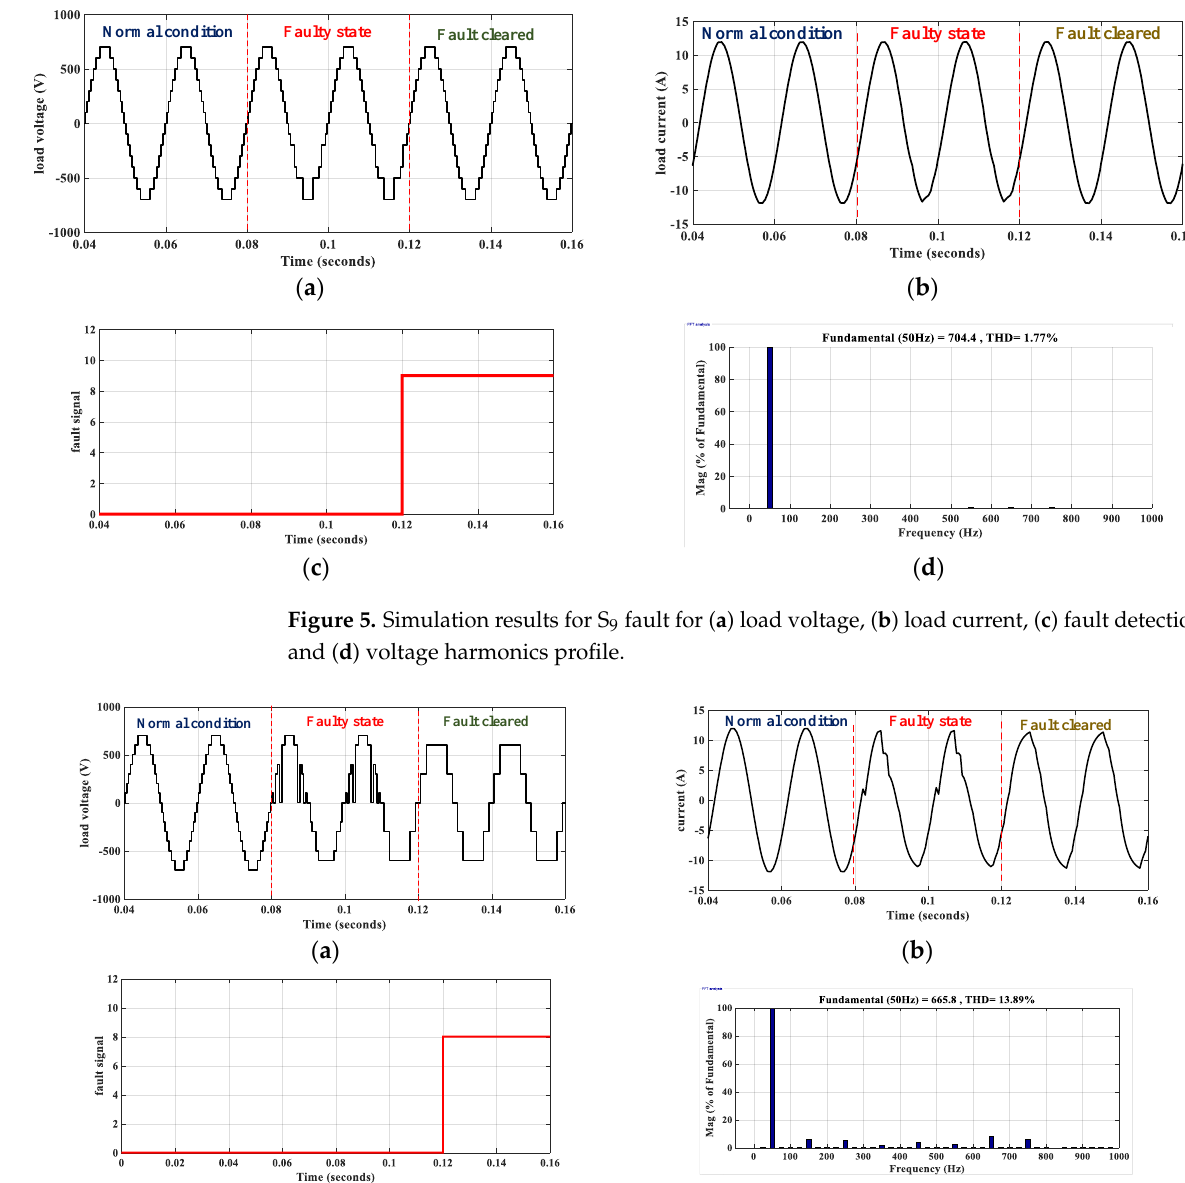
( f ) Figure 4. Simulation results of the proposed structure during healthy operation comprising ( a ) load voltage, ( b ) magnified view of load voltage, ( c ) load current, ( d ) magnified view of load current, ( e ) voltage harmonic characteristics acquired from Fourier analysis, and ( f ) current harmonic characteristics. 4.2. Fault-Tolerance Three situations can ensue from an open-circuit malfunction on an individual switch. However, due to inbuilt fault-tolerant operation, reduced voltage levels and diminished output power continue to be supplied at the load terminals. The first situation involves preserving every voltage level and consequently the output power rating post-detection and mitigation of fault. This is observed in the case of S1 or S9 fault, where redundant states are employed through modulation reconfiguration following fault detection. As for the second situation, in cases of open-circuited S2, S3, S4, S6, S7, S8, S10, or S11, the peak level 7 V dc is lost additionally, which expedites to decrement in output power rating as well. In case of a fault in S5, level 7 V dc is not lost, thus the output power rating is conserved.